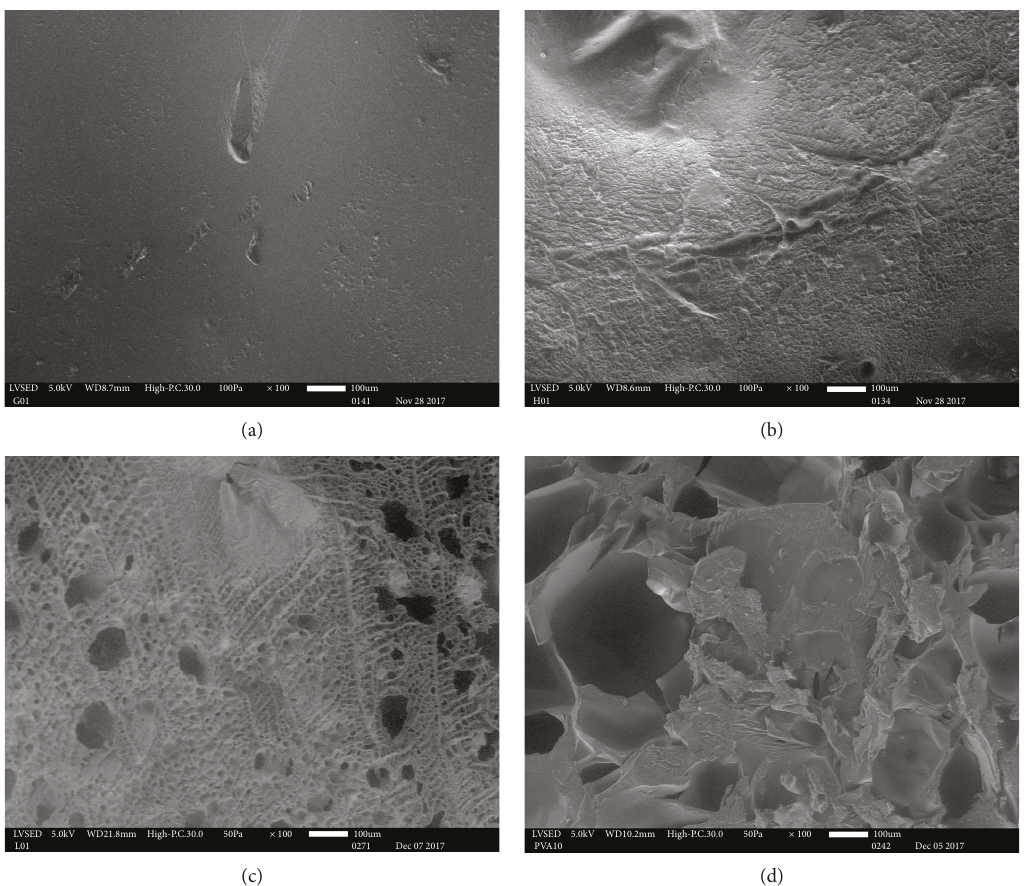
Figure 10: Scanning electron micrographs of hydrogels at 100x resolution. The samples used for this analysis were (a) 0.20 solely gelatin (20% gelatin), (b) H.6.20 (6% HOP and 20% of gelatin), (c) L.6.20 (6% LOP and 20% of gelatin), and (d) N.6.20 (6% NOP and 20% of